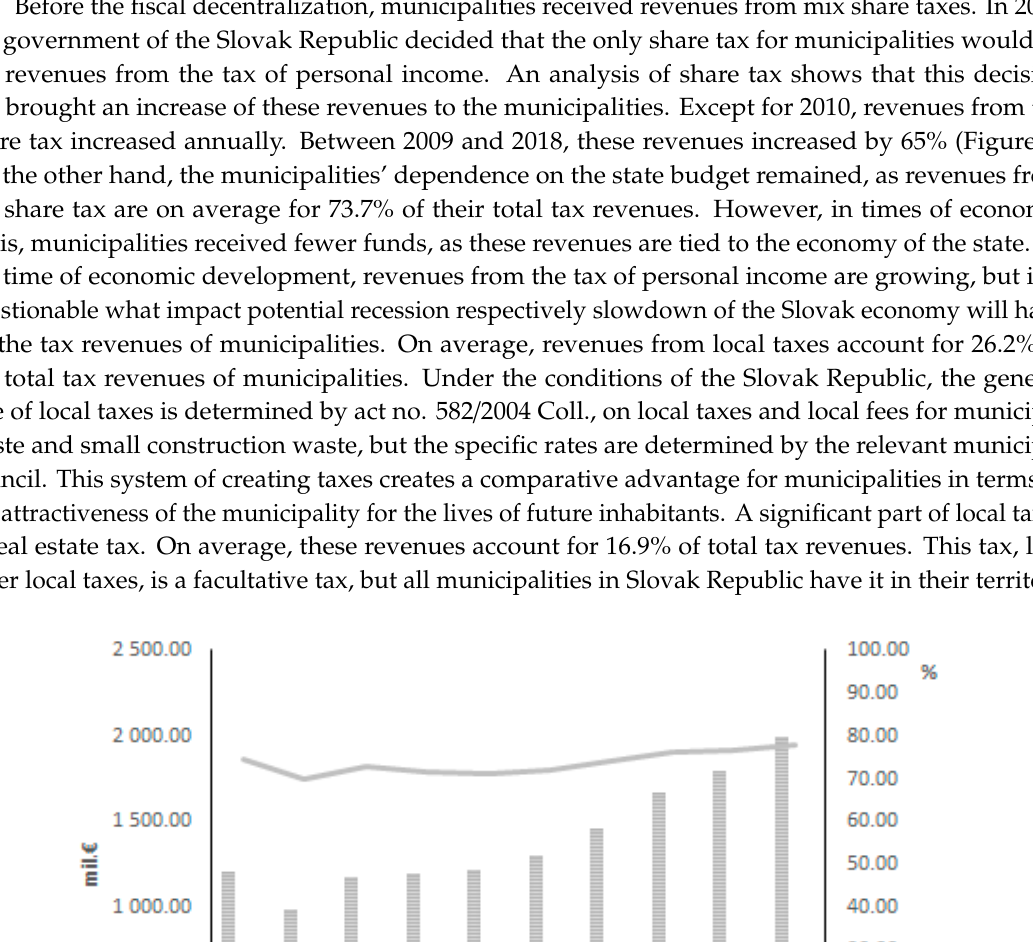
Figure 6. The share of individual categories of tax revenues of the municipalities in Czech Republic in the time period 2009–2018, Source: Czech Statistical Office, own processing. The results of our analyses are also confirmed by Vavrek and Adamisin (2018), who, in their research of the revenues part of municipal budgets in the Slovak and Czech Republics, note that although the state determines the amount of administrative fees without the possibility of their adjustment by the municipalities, it leaves them a certain freedom in determining the amount of local taxes and fees in both countries. Using the trend function, we analyze the trend of municipality revenues for the period from 2009 to 2018. The trend, used to model the time series, is chosen based on the interpolation criteria. For each time series we choose a trend function with a minimum value of 𝑅𝑀𝑆𝐸 and 𝑀𝐴𝐸 and